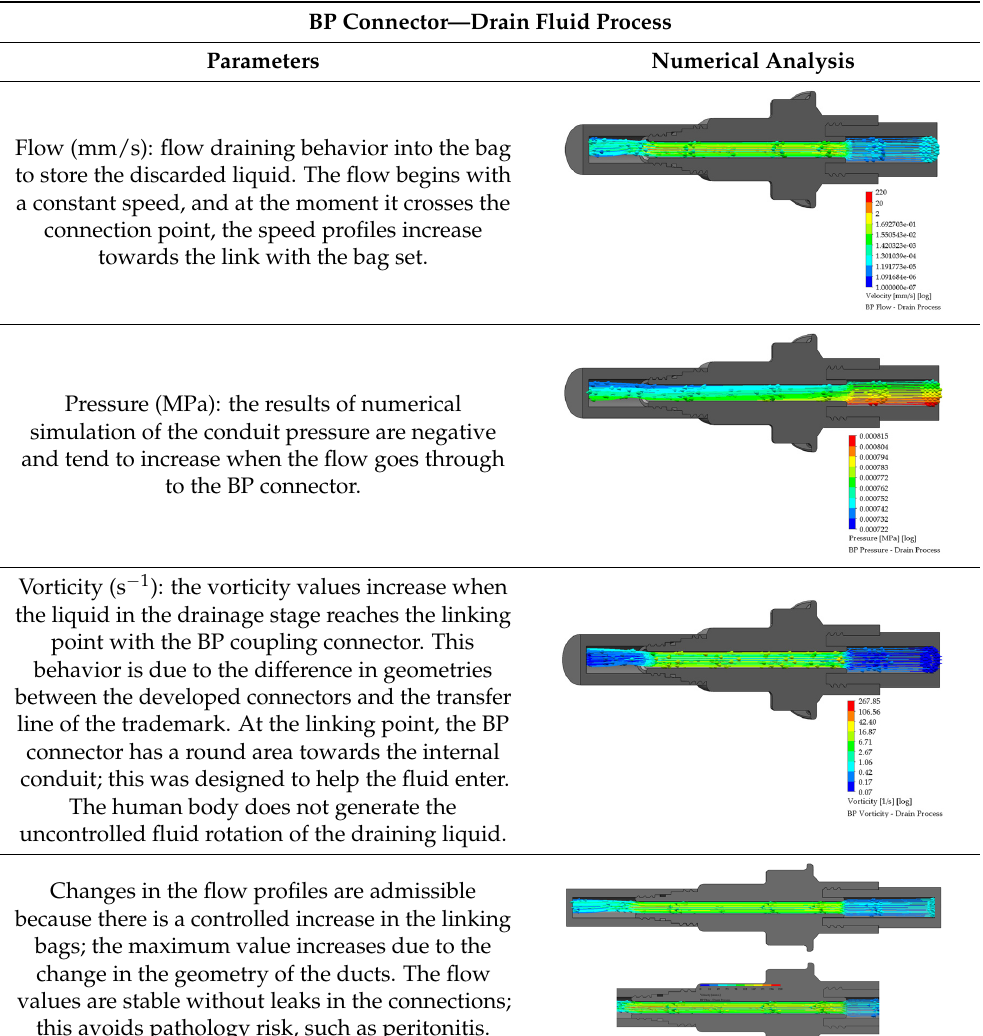
Table 5. Flow, pressure, and vorticity numerical analysis for PB connector—infusion fluid